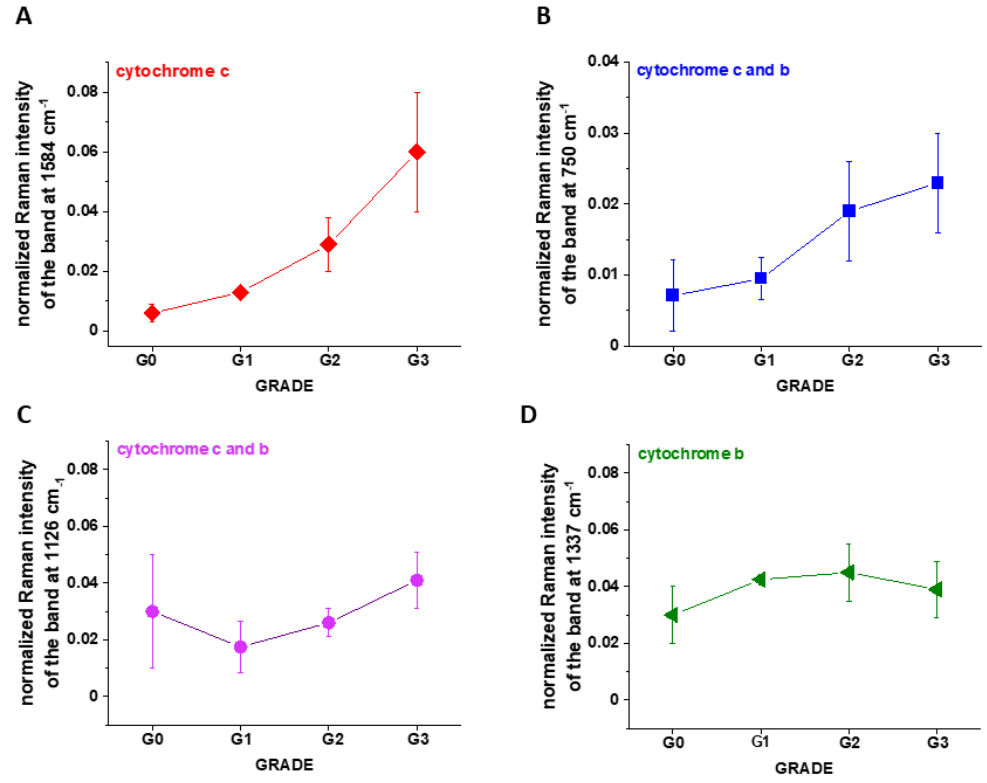
Figure 7. The Raman intensities of cytochrome c and cytochrome b in human breast tissue for n = 39: I 1584 ( A ), I 750 ( B ), I 1126 ( C ), I 1337 ( D ) as a function of breast cancer grade malignancy G0-G3 at excitation 532 nm (A). The results are presented as the mean ± SD. Raman bands intensity were taken from normalized by vector norm spectra.